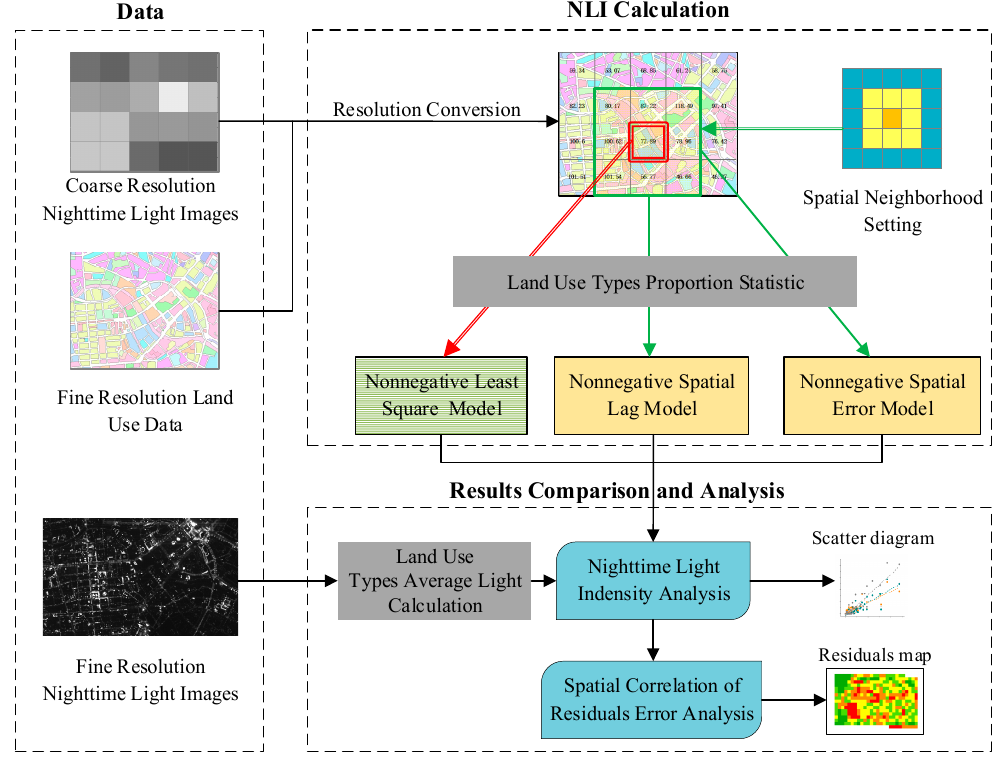
Figure 1. Experimental framework for comparing R 2 with reference data and residual errors between the proposed non-negative spatial autoregressive models and nonnegative least square (NLS) model.